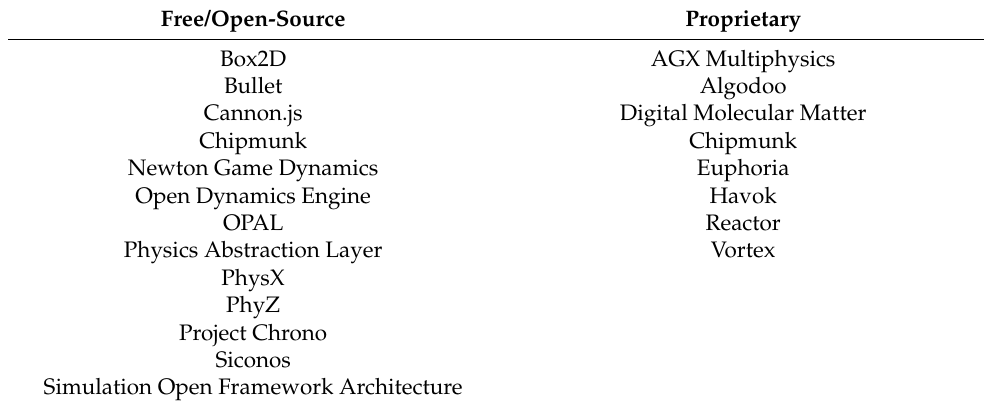
Table 6. Physics